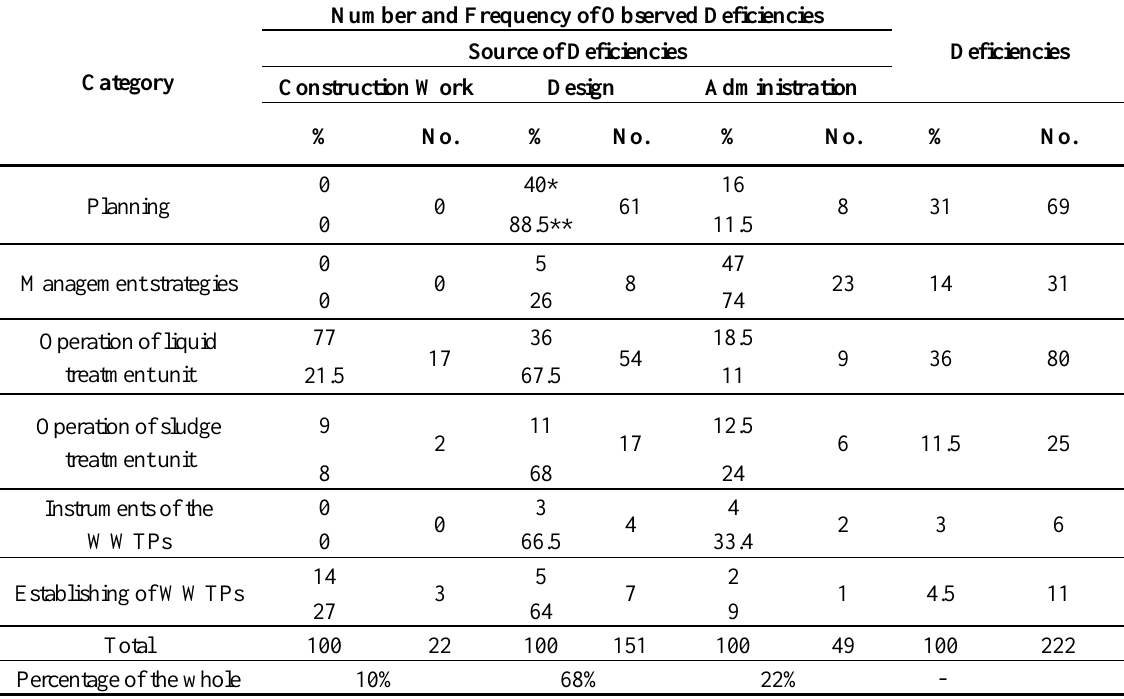
Table 3. Different deficiencies observed, divided by category and source of deficiency.